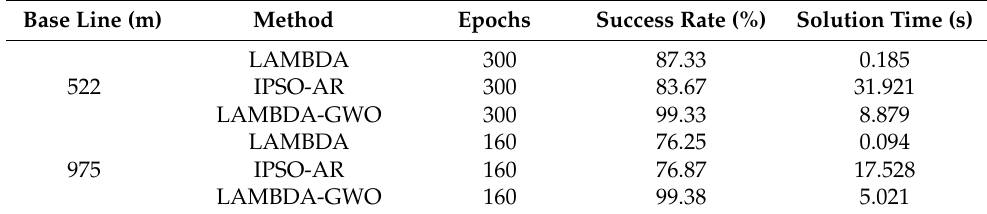
Table 1. Comparsion of three methods. Base Line